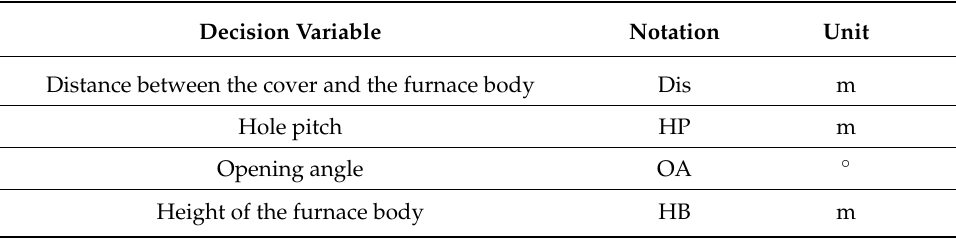
Table 1. The decision variables in the